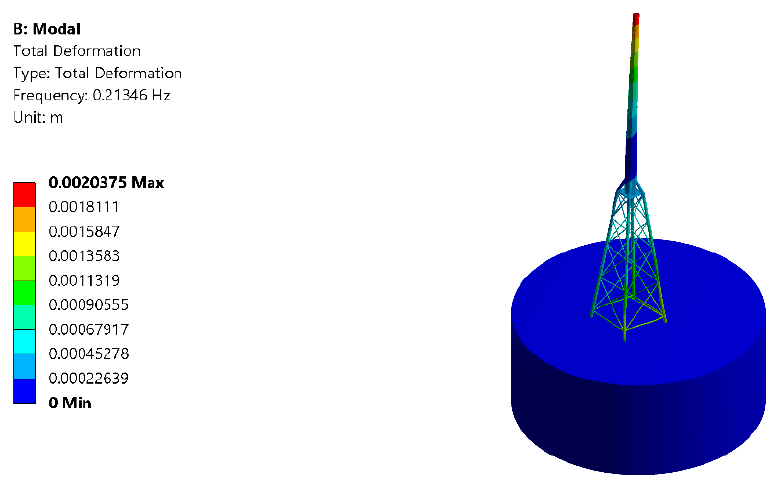
Figure 6. Display of structural model’s modal analysis results showing the first mode frequency.